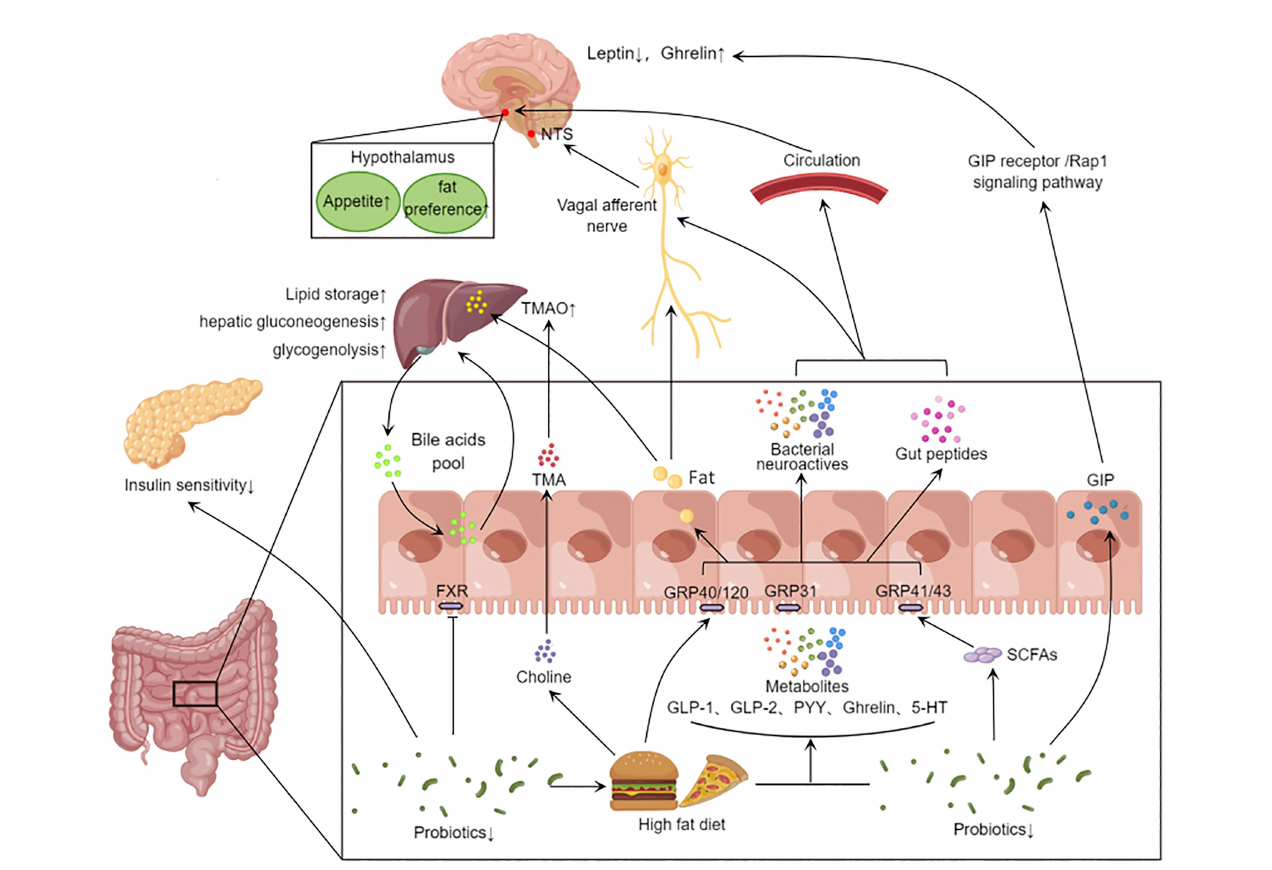
FIGURE 2 Gut microbiota affects systemic metabolism through gut-brain axis and gut-liver axis. Eating stimulates the secretion of intestinal peptides (GLP-1, GLP-2, PYY, Ghrelin, GIP, etc.) in the gut. High-fat diet reduces the abundance of beneficial bacteria, and the gut microbiota can convert food into SCFAs and 5-HT neurotransmitters. These metabolites activate different receptors and act on central appetite regulation via the vagus nerve or blood–brain barrier. On the other hand, the disrupted microbiota inhibits FXR signaling and affects the bile acid pool. The gut microbiota also further metabolizes fat and choline from the high-fat diet through the portal vein into the liver, affecting hepatic lipid synthesis, gluconeogenesis, and glycogenolysis. In addition, microbial metabolites can also lead to other peripheral effects. The decrease in the abundance of probiotics will reduce GLP-1 secretion, inhibit insulin signaling pathway and fat beige. GLP-1, Glucagon-like protein 1; GLP-2, glucagon-like egg 2; PYY, Peptide YY; GIP, glucose-dependent insulinotropic polypeptide; 5-HT, 5-hydroxytryptamine; SCFA, short chain fatty acids; FXR, Farnesoid X Receptor; The TMA, Trimethylamine; TMAO, Trimetlylamine oxide; NTS, nucleus tractus